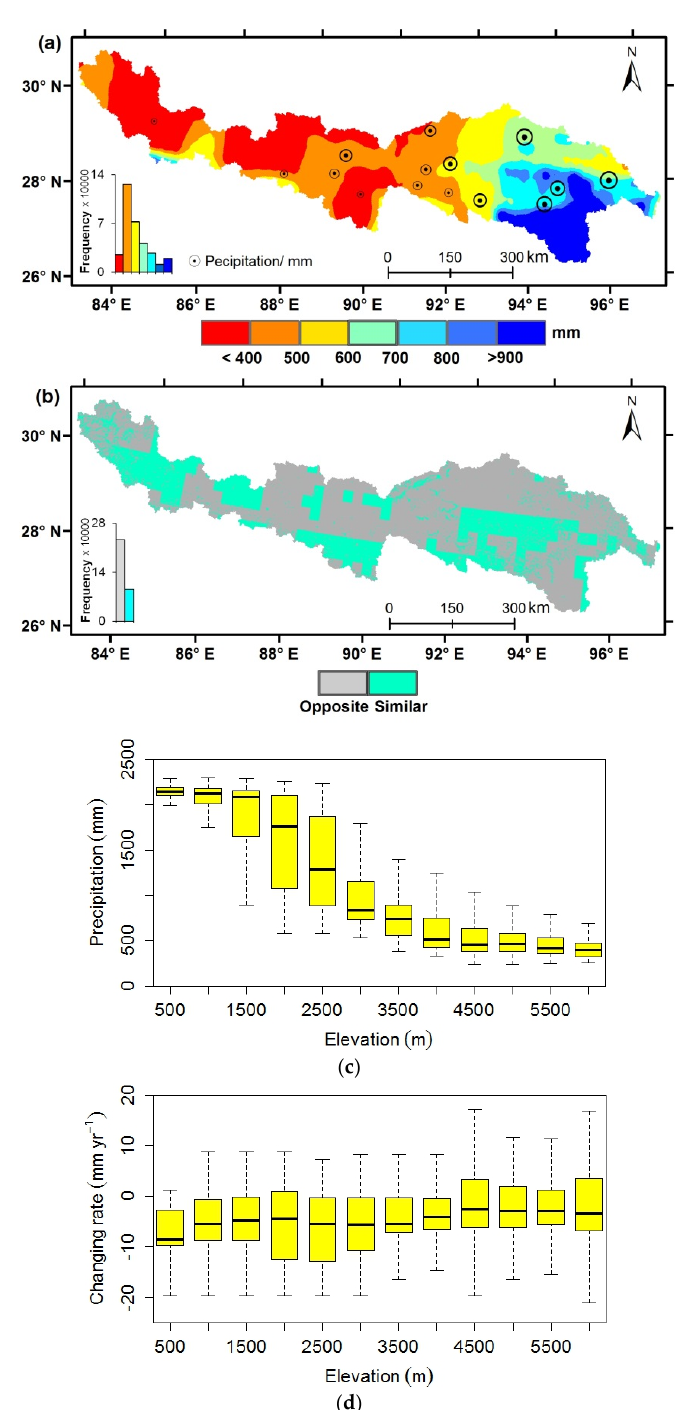
Figure 8. Spatial distribution of TRMM-derived precipitation ( a ), trend analysis between TRMM-derived precipitation changing rate and greening rate ( b ), vertical pattern of TRMM-derived precipitation ( c ), and TRMM-derived precipitation changing rate ( d ) against elevation from 500 m to 6000 m in the YZR basin during 1999–2013. (a) The range of station-observed precipitation is from 200 mm to 841 mm; (b) the grey means an opposite trend, the cyan indicates a similar trend; (c) and (d) the box-and-whisker plot is produced from the 25th to 75th percentiles at the ends of the box, the median is indicated with a horizontal line in the interior of the box, and the maximum and minimum are at the ends of the whiskers.